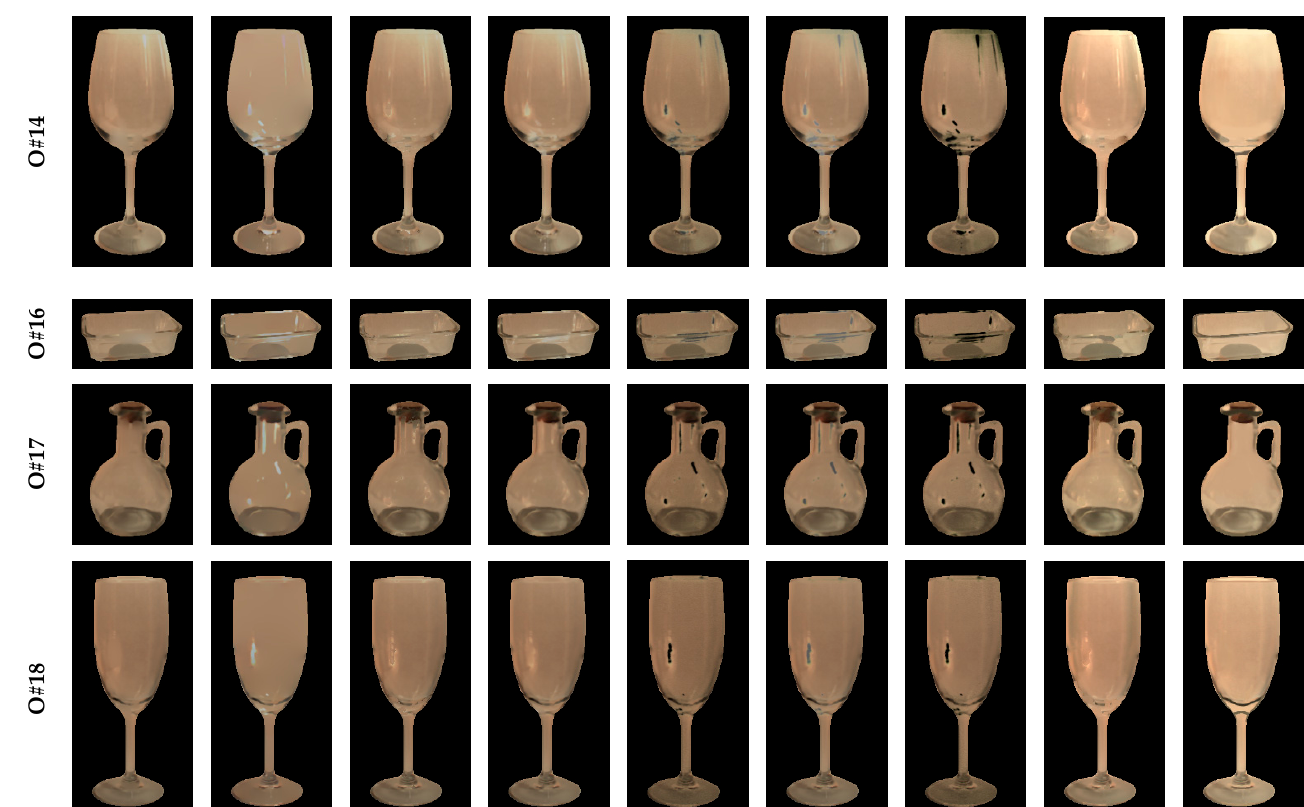
Figure A3. Comparison of SRI accuracies of different methods for sample objects in MSPLFI dataset. Evaluation results for SRI performances of proposed method for 122 specular reflection suppressed images (121 sub-aperture + 1 maximum ones) of 9 sample objects separately using different SRI metrics.